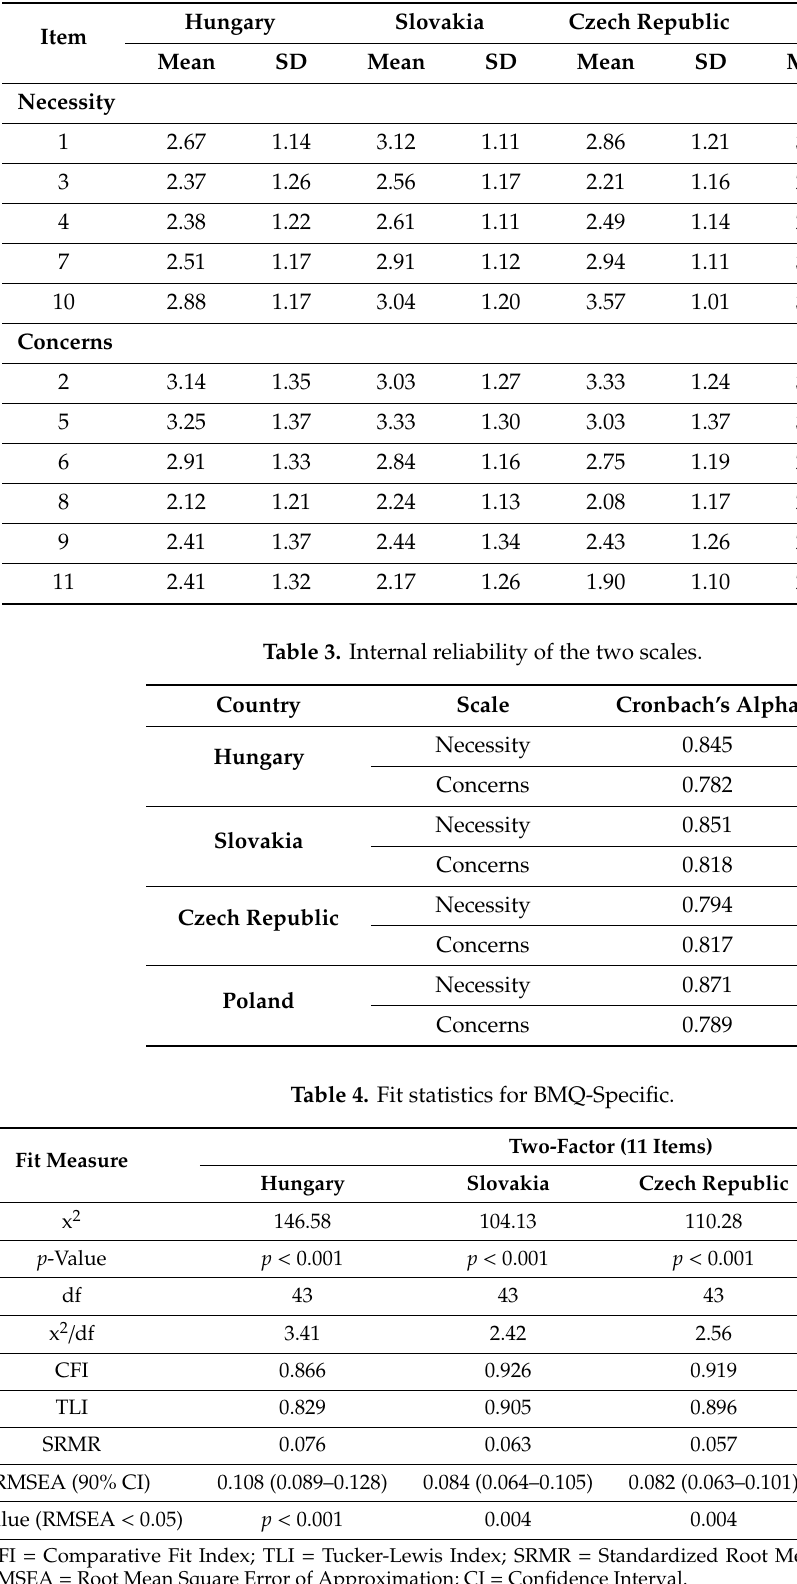
Table 2. Descriptive statistics of the Beliefs about Medicines Questionnaire (BMQ)-Specific items.